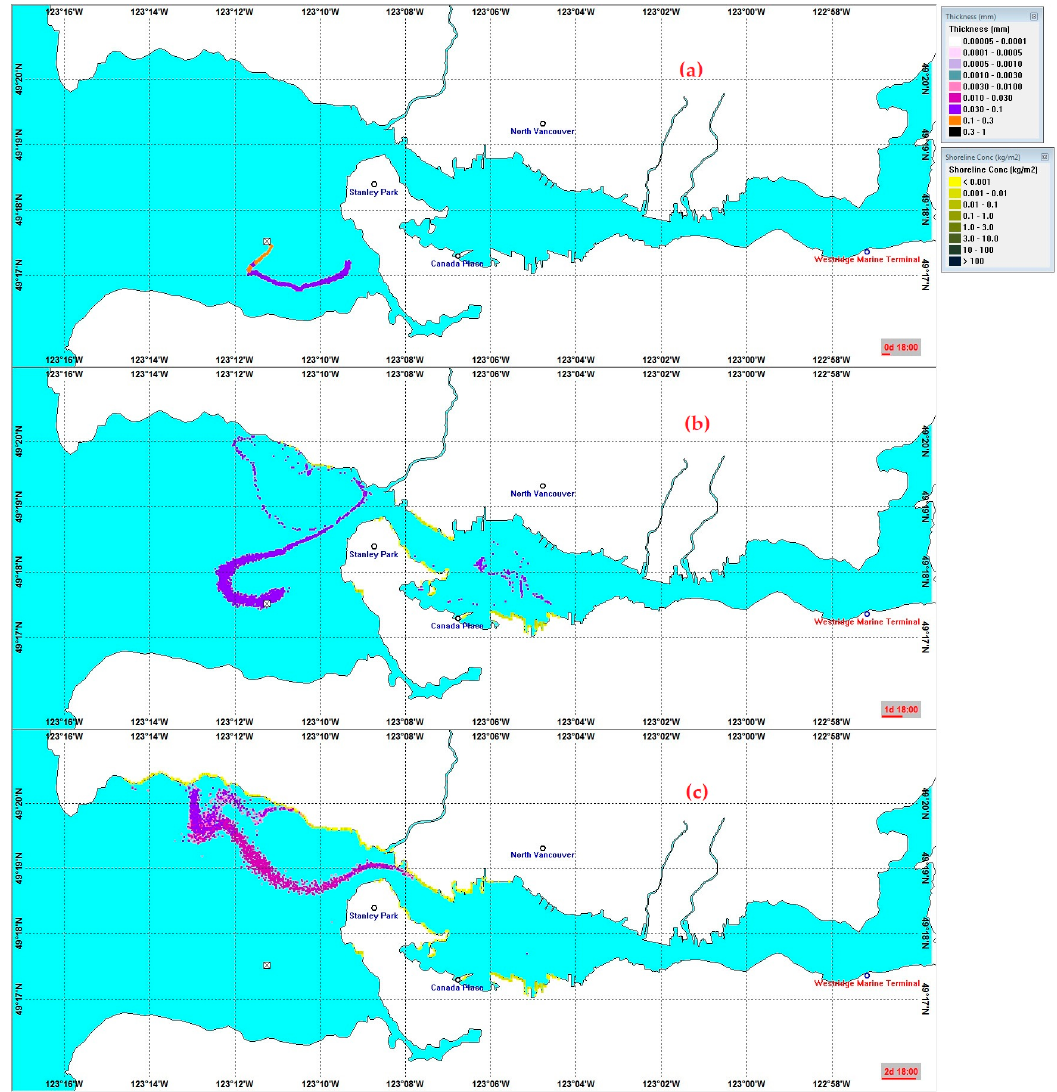
Figure 12. Example of oil trajectories for the oil spill that started to discharge at 14:00 on 8 April 2015. Spilled oil discharged continuously (22 h) and then tracked with wind and without recovery actions (labeled as Scenario #4 in Table S5). Figures from top to bottom are oil distribution at 8:00 on ( a ) 9 April, ( b ) 10 April and ( c ) 11 April 2015.